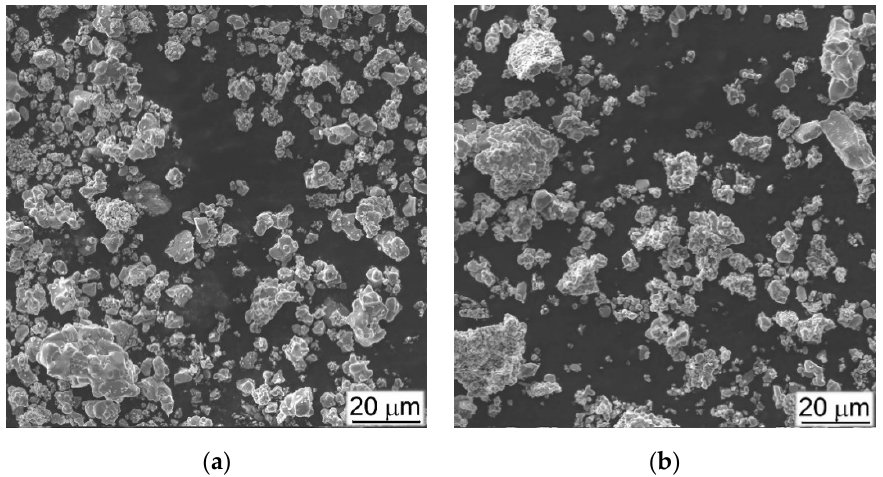
Figure 3. SEM Images (SE) of ( a ) TiC and ( b ) TiB 2 particles used in preparation of Ti64BEPM + XTiC and Ti64BEPM + XTiB MMCs.